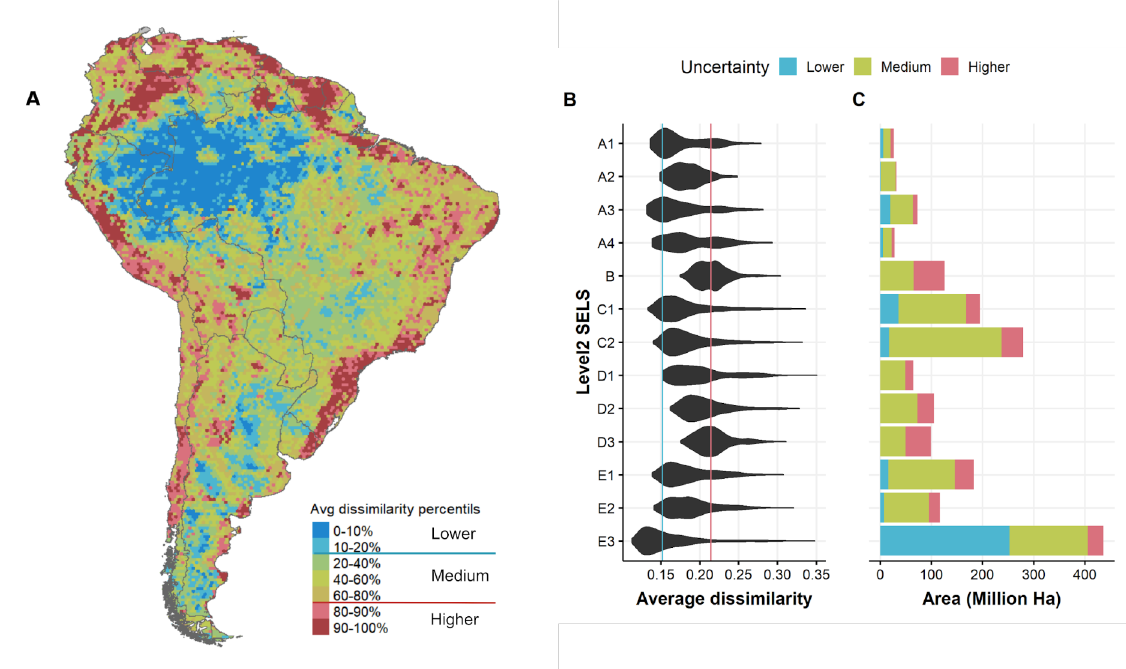
Fig. A2.1. Classification uncertainty map (A), the distribution of uncertainty values by SELS (B), and the area under each category (C). The level of uncertainty for a hexagon belonging to a SELS was calculated as the average dissimilarity between that hexagon and the rest of hexagons within the same SELS. Greater dissimilarity means greater deviation of that hexagon respect to the average SELS characteristics. These figures help distinguishing areas where the classification was more consistent from those where it was less representative due to the heterogeneity of the territory. We labeled the 20% of hexagons with lower uncertainty (blue), the 20% of higher uncertainty (red), and the rest 60% medium uncertainty